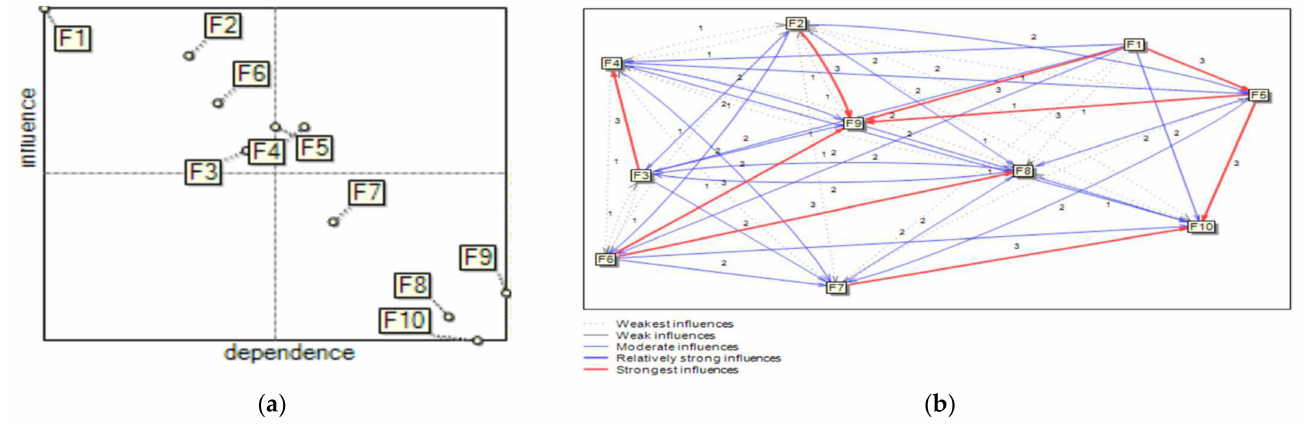
Figure 4. Direct influence/dependence map ( a ) and graph ( b ) for SCFs with a defined power of